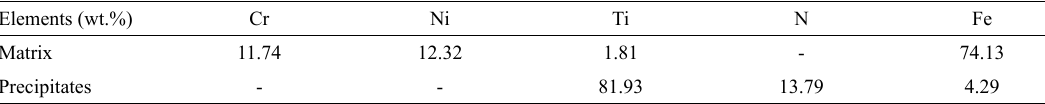
showing the titanium nitride. EDS analysis on precipitate and matrix is shown at Table 3. Table 3. Chemical composition of matrix and precipitate of Figure 1. Elements